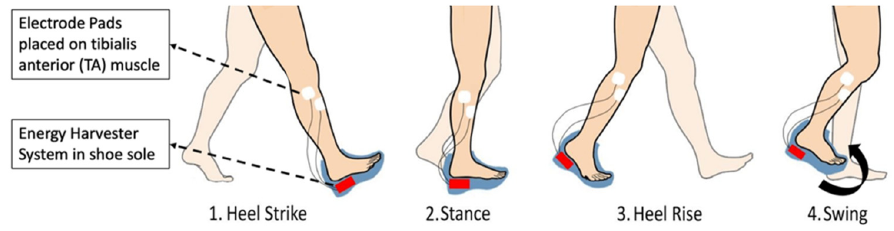
Figure 1. Visualization of the energy-harvesting system within the human-gait cycle.